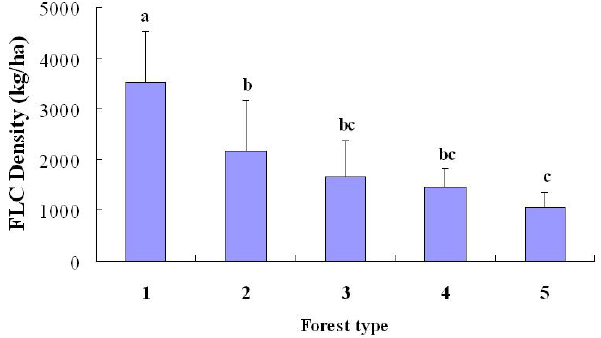
Fig. 4. FLC density under typical forest types in Zhejiang province: Fig. 4 FLC density under typical forest types in Zhejiang province: 1. Broad-leaved forest; 2. Mixed coniferous broad-leaved forest; 3. Coniferous forest; 4. Moso bamboo forest; 5. Economic forest. Different letters mean significantly different at 0.05 level.